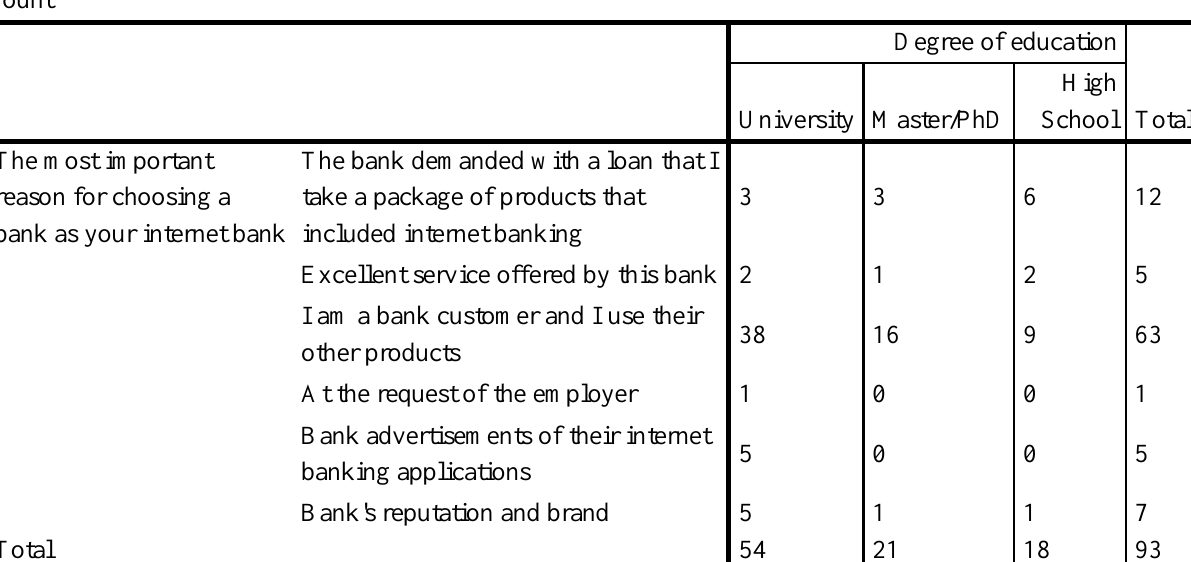
Table 7. Reasons for choosing business bank vs education level crosstabulation